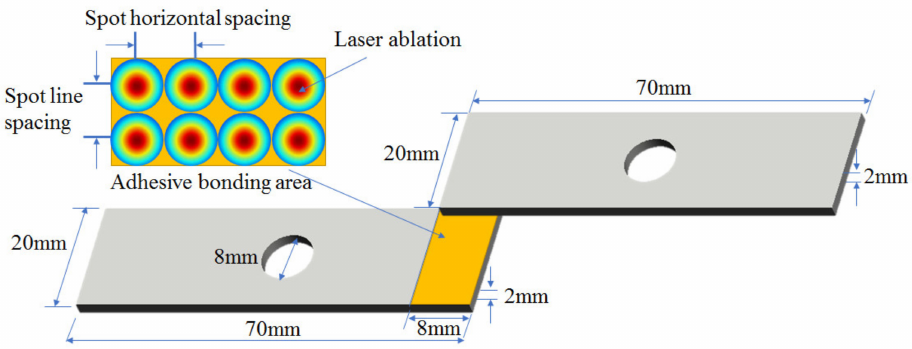
Figure 1. Schematic diagram of adhesive bonding of Al alloy